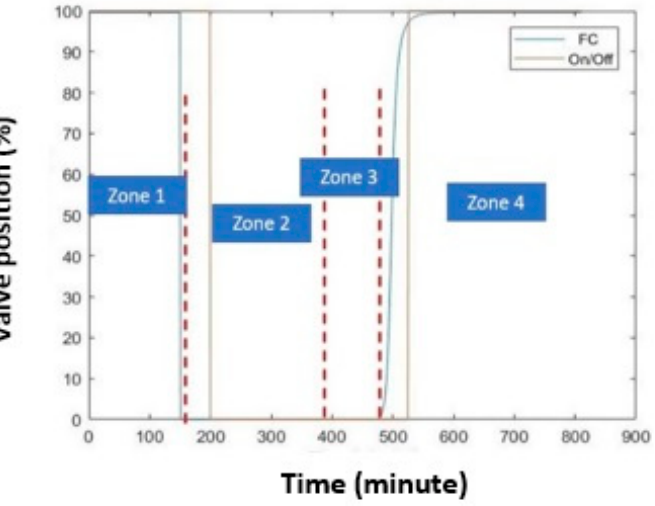
Figure 12. Valve position variations by using a fuzzy controller (FC) and On/Off controller during experimentation in a theoretical classroom with a medium size. Zone: It remarks different conditions during the experiments.